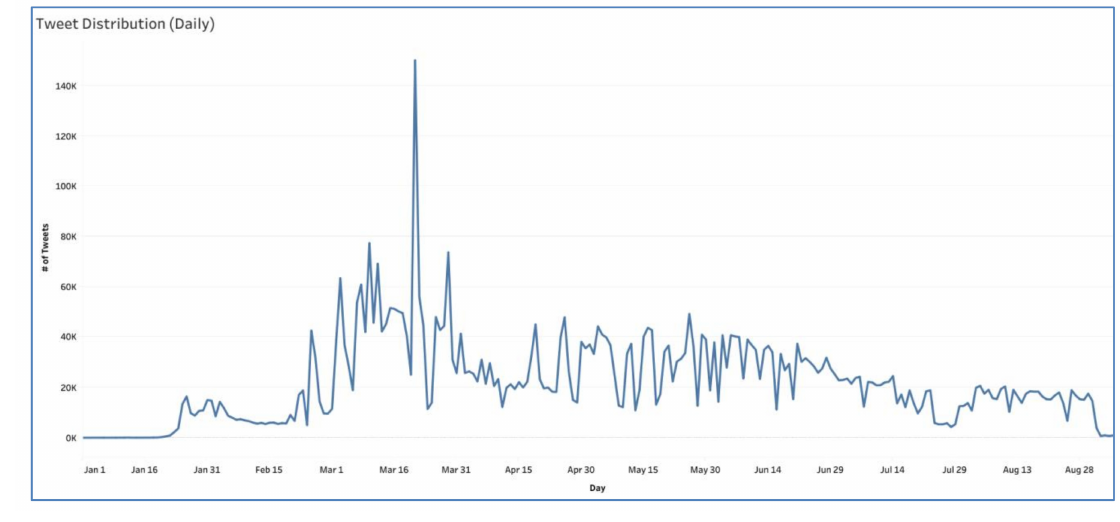
Figure 2. Tweets Distribution (Daily).